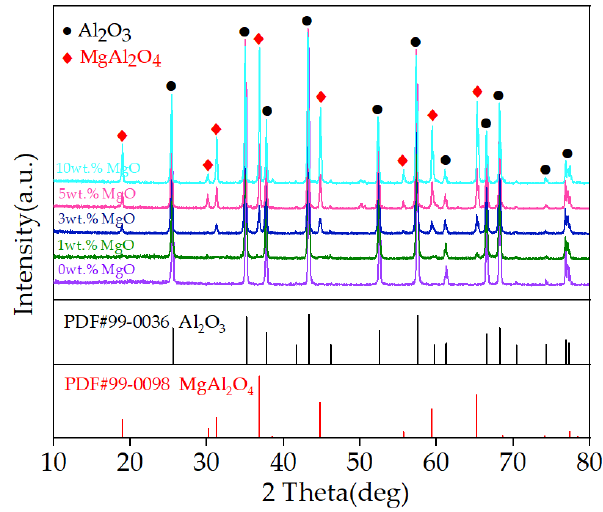
Figure 5. XRD patterns of the Al 2 O 3 powders with different MgO doping contents.